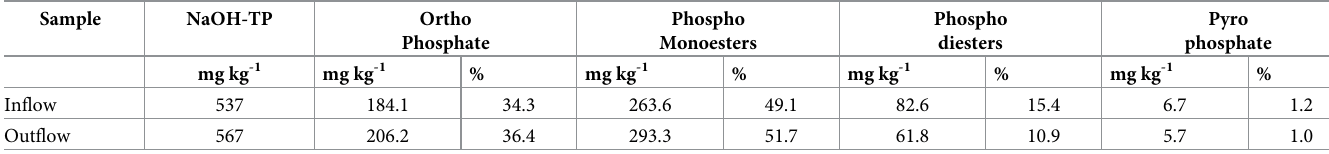
Table 2. Organic P forms (mg kg -1 ) of NaOH EDTA extractions in inflow and outflow samples collected from ditch 3. Sample NaOH-TP Ortho Phosphate Inflow